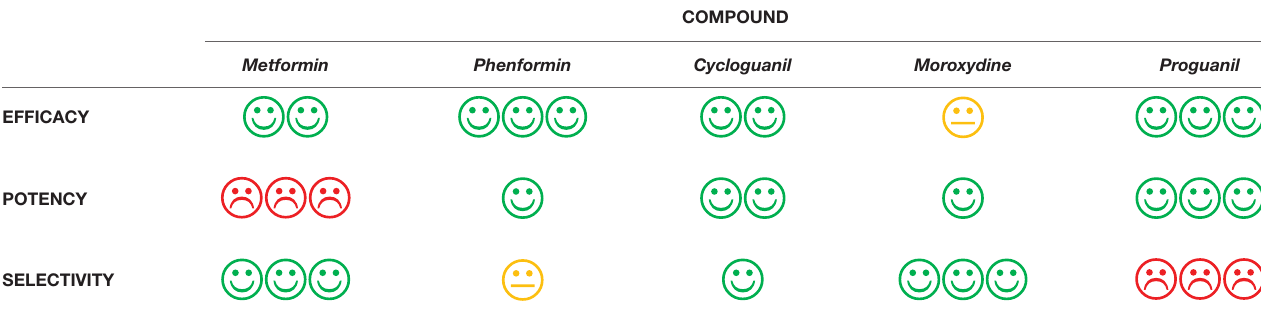
FIGURE 9 | Effect of biguanides on the viability of cells in which CLIC1 associated membrane current is not relevant for cell proliferation. Concentration-response curves of metformin (MET), phenformin (PHEN), cycloguanil (CG), moroxydine (MOR), and proguanil (PG) in differentiated GBM cells (A) and ucMSCs (B) . Cell viability was assessed by MTT reduction test, after 48 h of treatment. Data are the mean of n = 3 experiments performed in quadruplicate, on cells derived from 5 GBMs (for metformin: GBM1, 2, 3, 4, 6, 7) and 3 GBMs (for phenformin, cycloguanil, moroxydine, and proguanil: GBM2, 3, 4) and 4 independent ucMSC cultures. For sake of clarity statistical significance is reported in Supplementary Table S1 . The comparison of the effects of biguanides in GSCs and differentiated cells from the same GBM is reported in Supplementary Figure S6 . TABLE 3 | Graphical representation of the pharmacological features of the different biguanides tested as antitumor agents, evaluating EFFICACY (maximal antiproliferative effects), POTENCY (IC 50 ), and SELECTIVITY (toxic effects induced via a mechanism independent from CLIC1 inhibition, occurring in cells different from